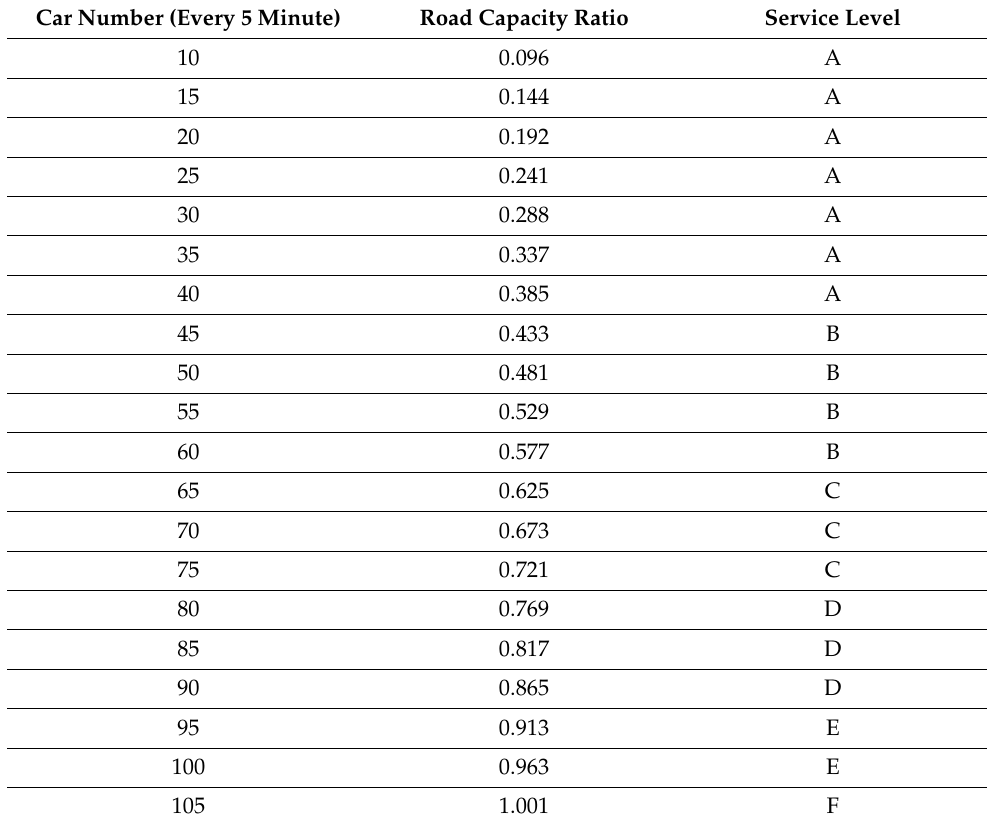
Table 10. The road occupancy ratio (United States